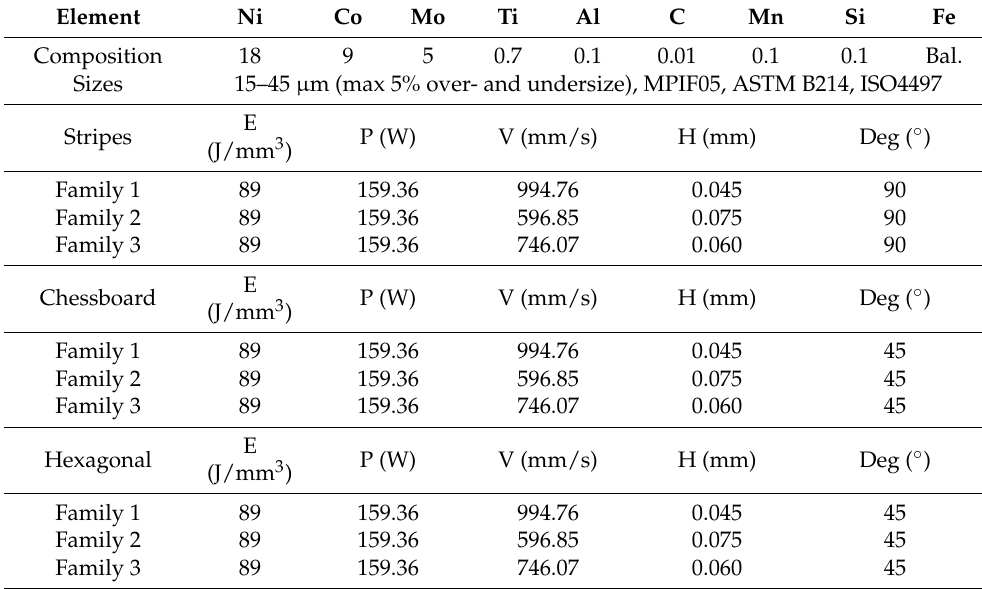
Table 1. Material supplier specification and process parameter setting for the experiments made.